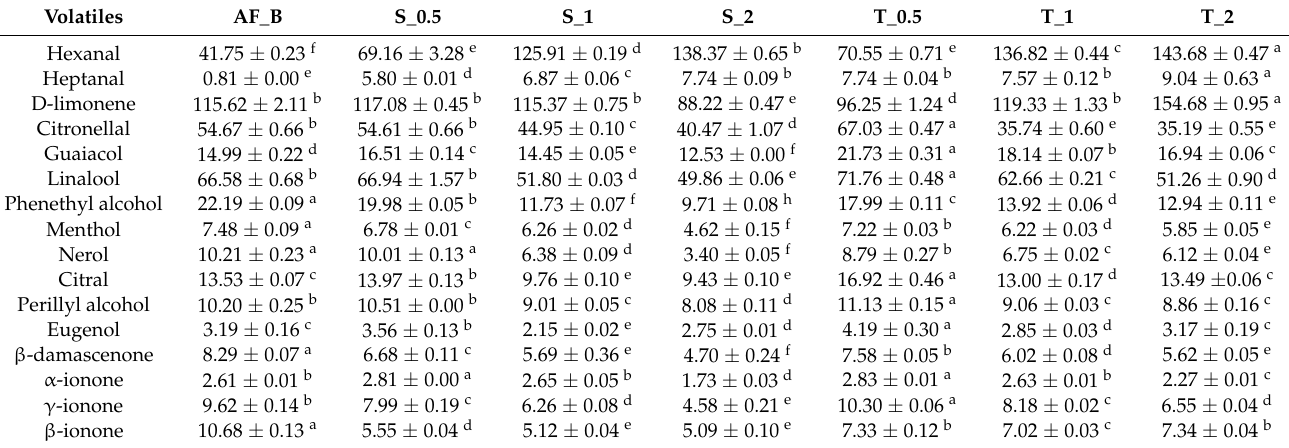
Table 6. Volatile compounds ( µ g/kg) in formulated